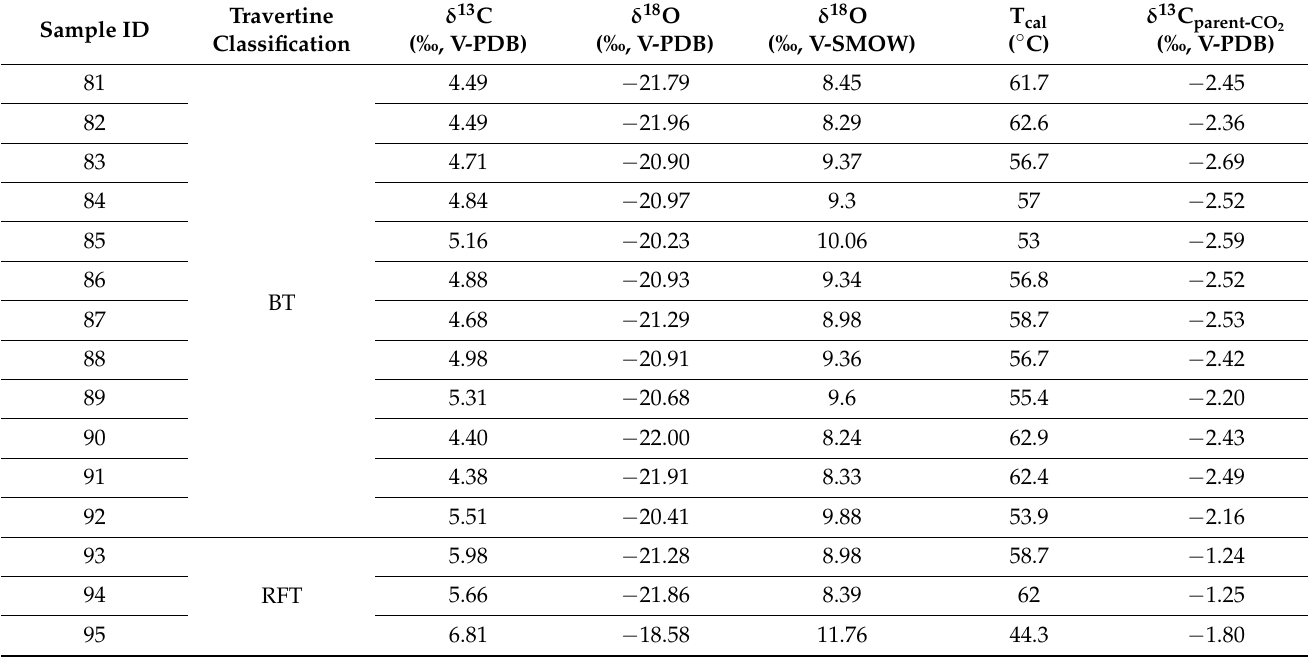
travertines; RFT = recently formed travertines.